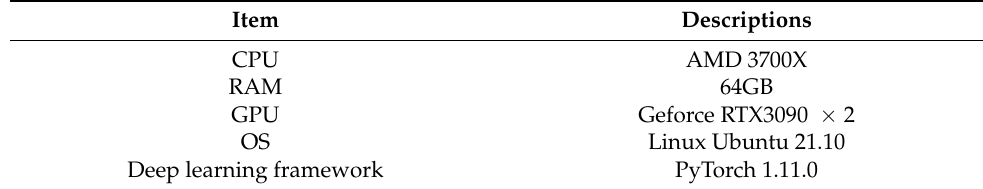
Table 2. Hardware and software environment.